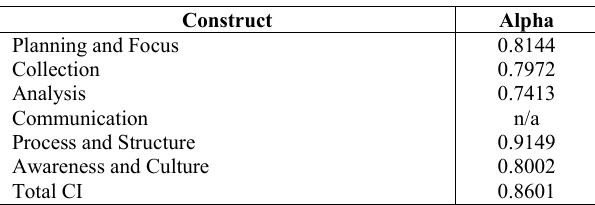
Table 14: Alpha Cronbach values for constructs Construct Alpha Planning and Focus